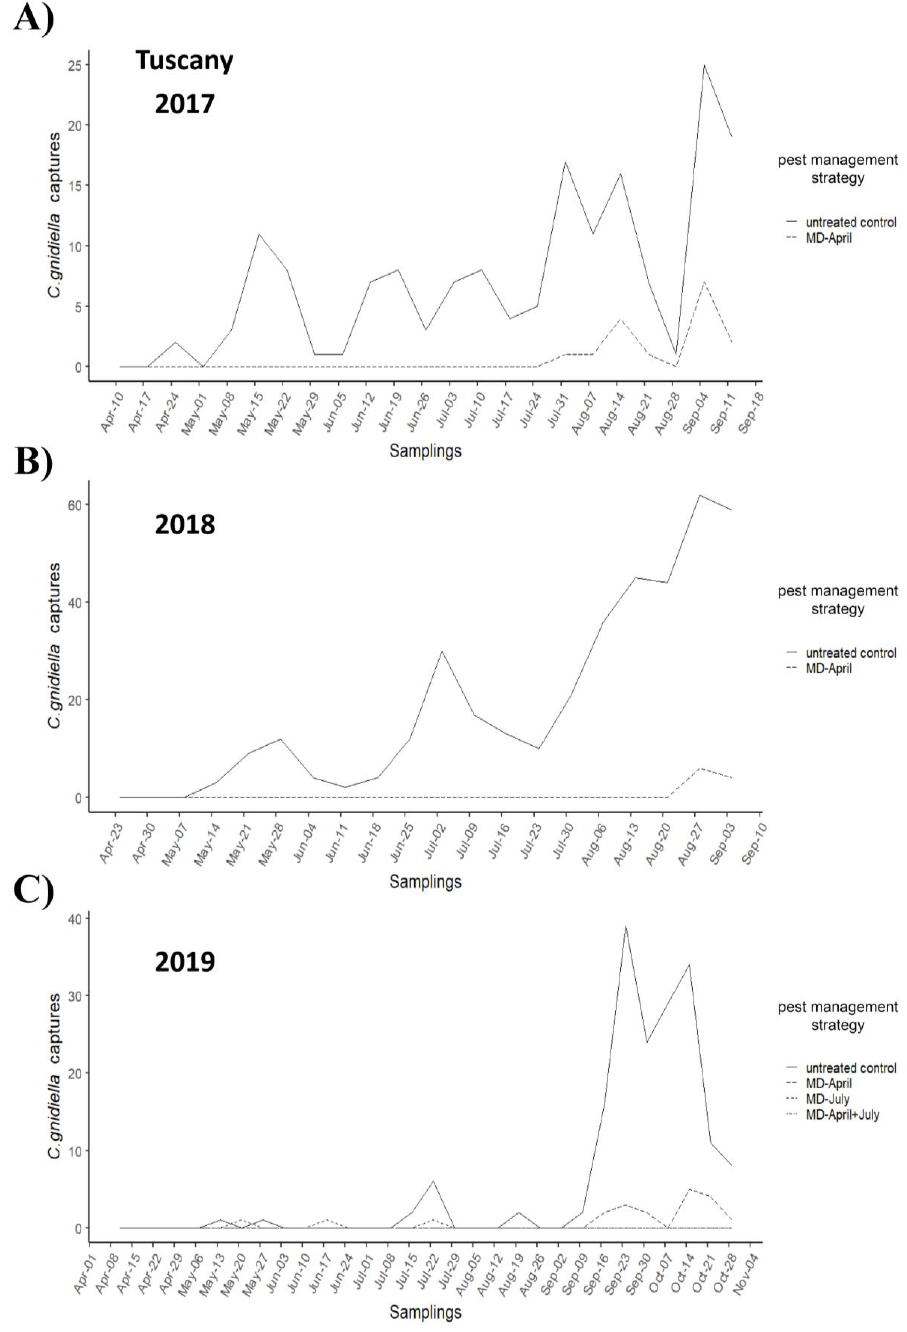
Figure 1. Cryptoblabes gnidiella flight trends in mating disruption (MD)-managed and untreated control plots in Tuscany in 2017 ( A ), 2018 ( B ), and 2019 ( C ). In all years, there is a marked contrast in the number of catches between plots under MD (dashed lines) and untreated control plots (solid line), especially from August onwards.